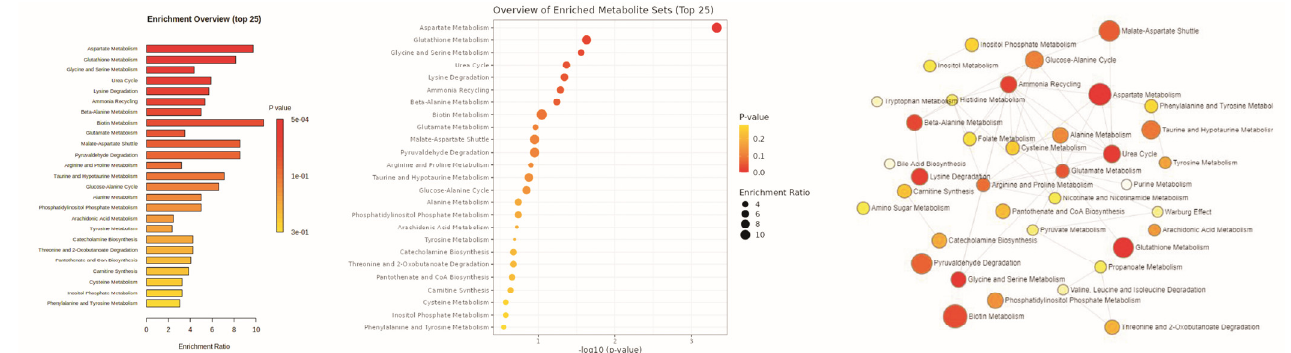
Figure 4. Metabolite set enrichment analysis: The aspartate, glycine, serine, and glutathione metabolic pathways are the most significantly affected in the upper panel; four upregulated FDR = 2.99 × 10 − 1 and 4/20; FDR = 1.00 in the lower panel; there are four dysregulated features out of 20; false discovery rate (FDR) = 1.00).